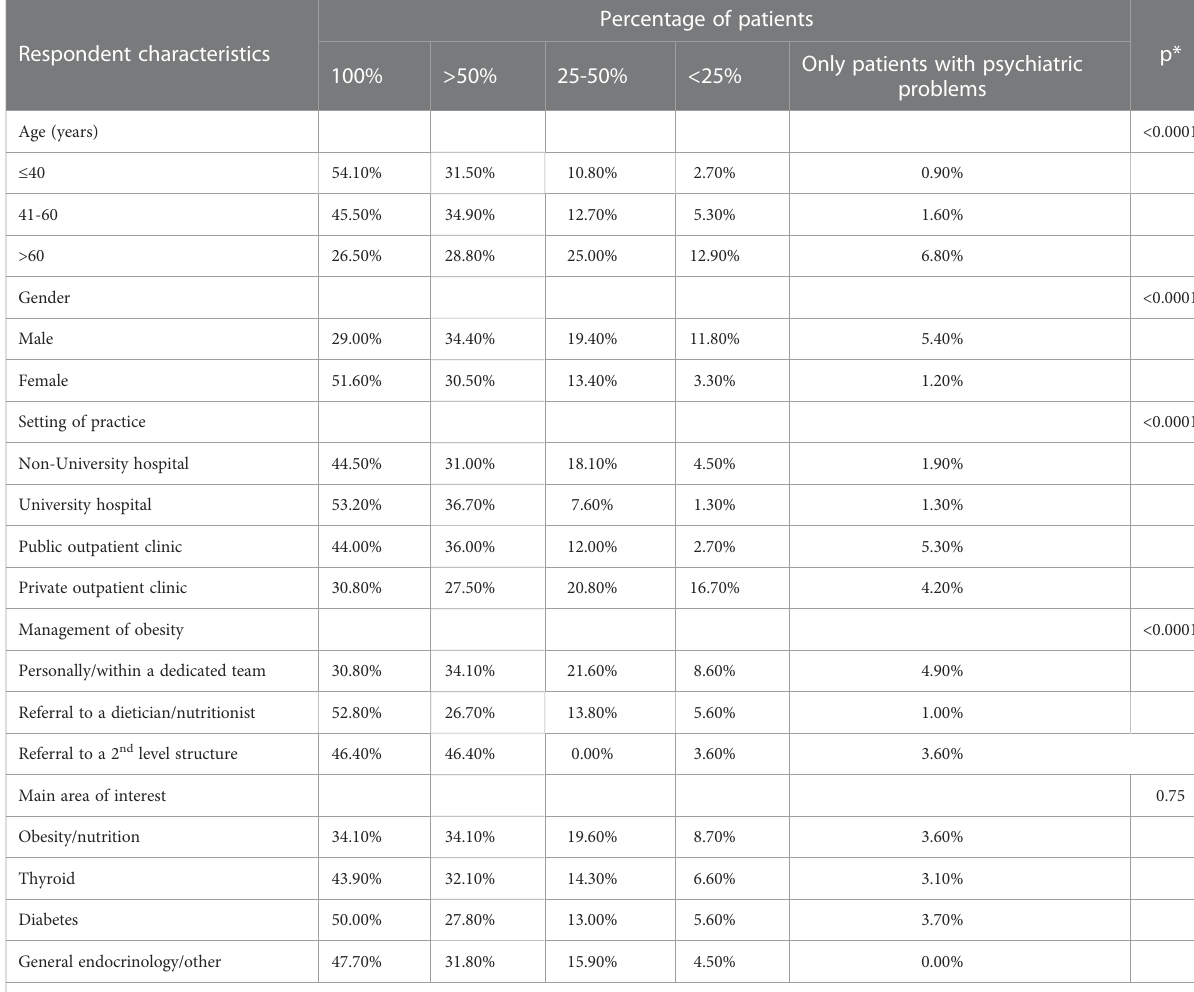
TABLE 6 Reported percentage of patients to whom psychological support should be recommended by respondent